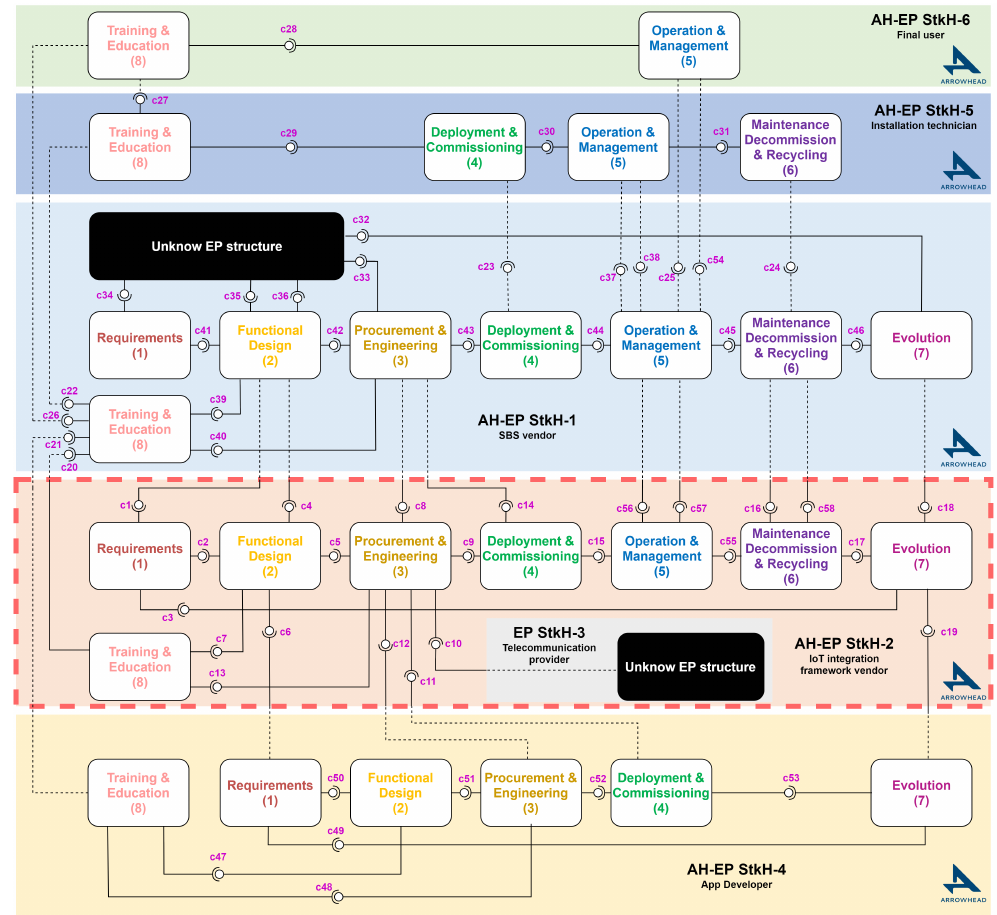
Figure 8. Arrowhead-EP (AH-EP) description of the Smart Boiler use case using a graph based on the Arrowhead-EP